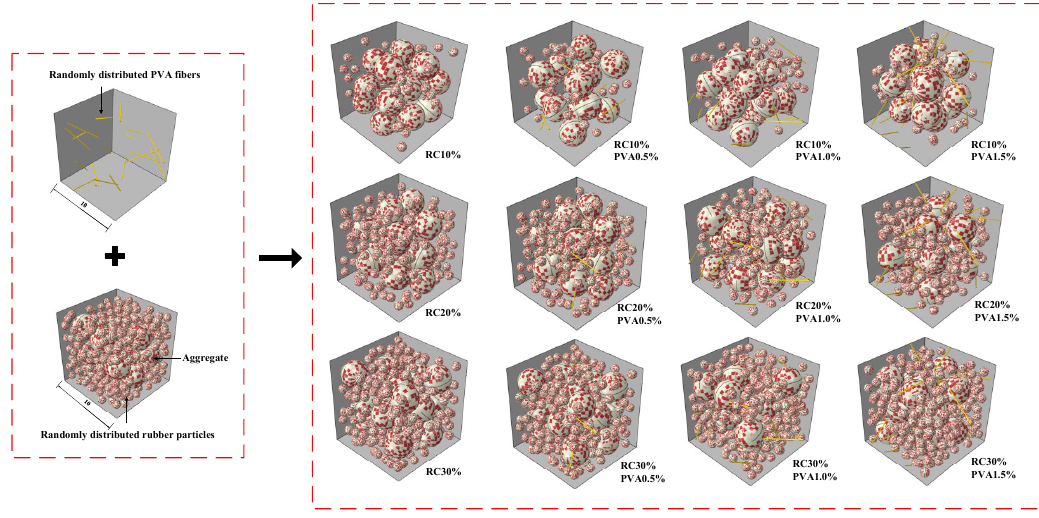
Figure 11. Three-dimensional mesomodel with different dosages.